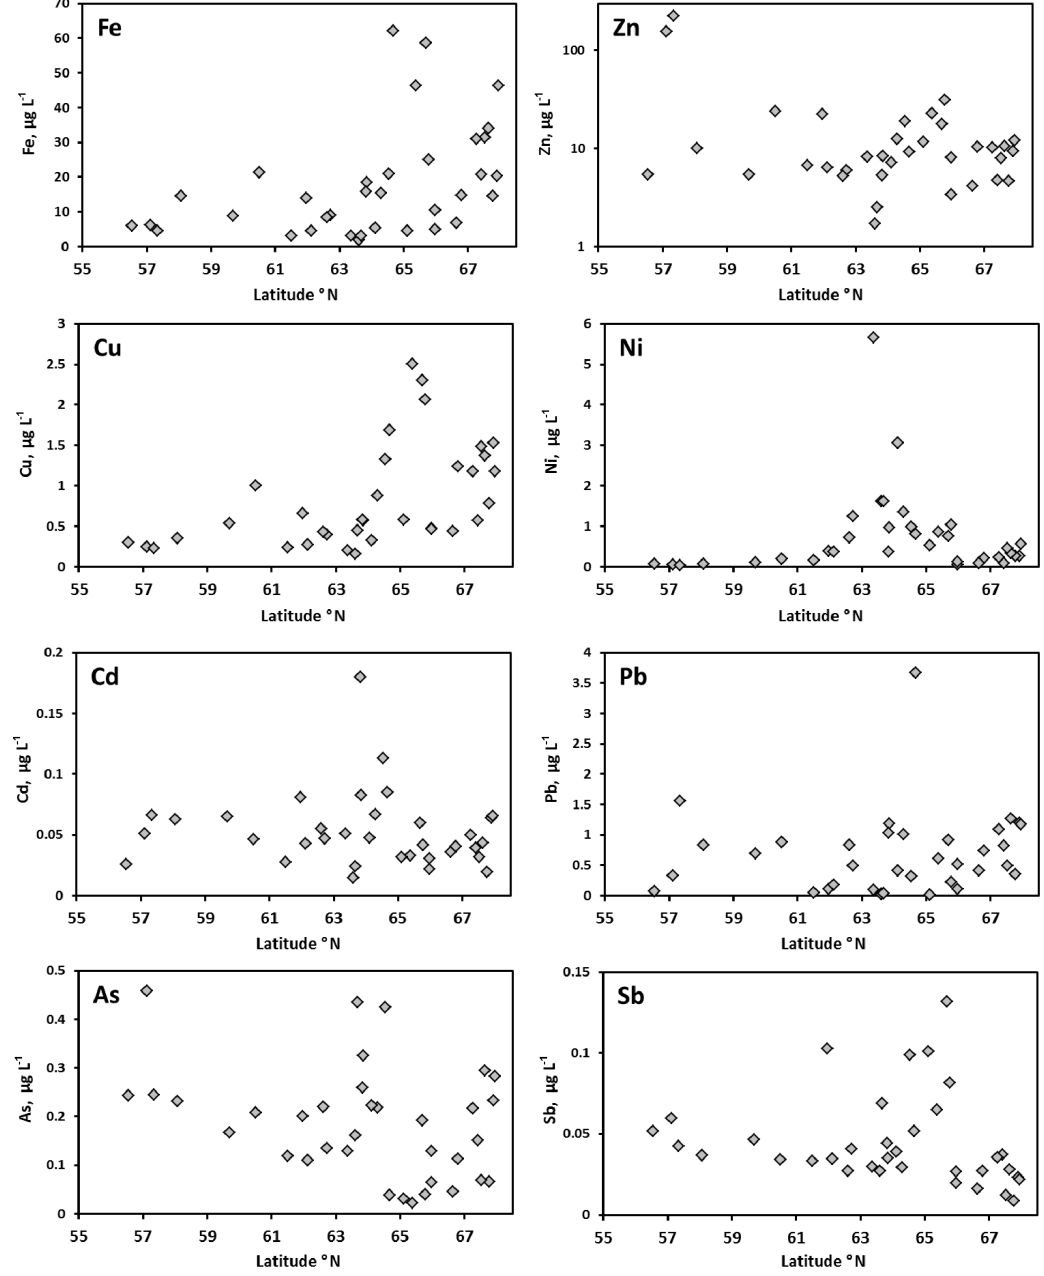
Figure 2. Examples of dissolved (<0.45µm) metal concentrations in snow water as a function of latitude. The cause for the elevated concentrations of Ni, Cd and Sb at ca. 64–65 ◦ N is most likely industrial impact, but given relatively low number of data points around industrial centers it is hard to prove it